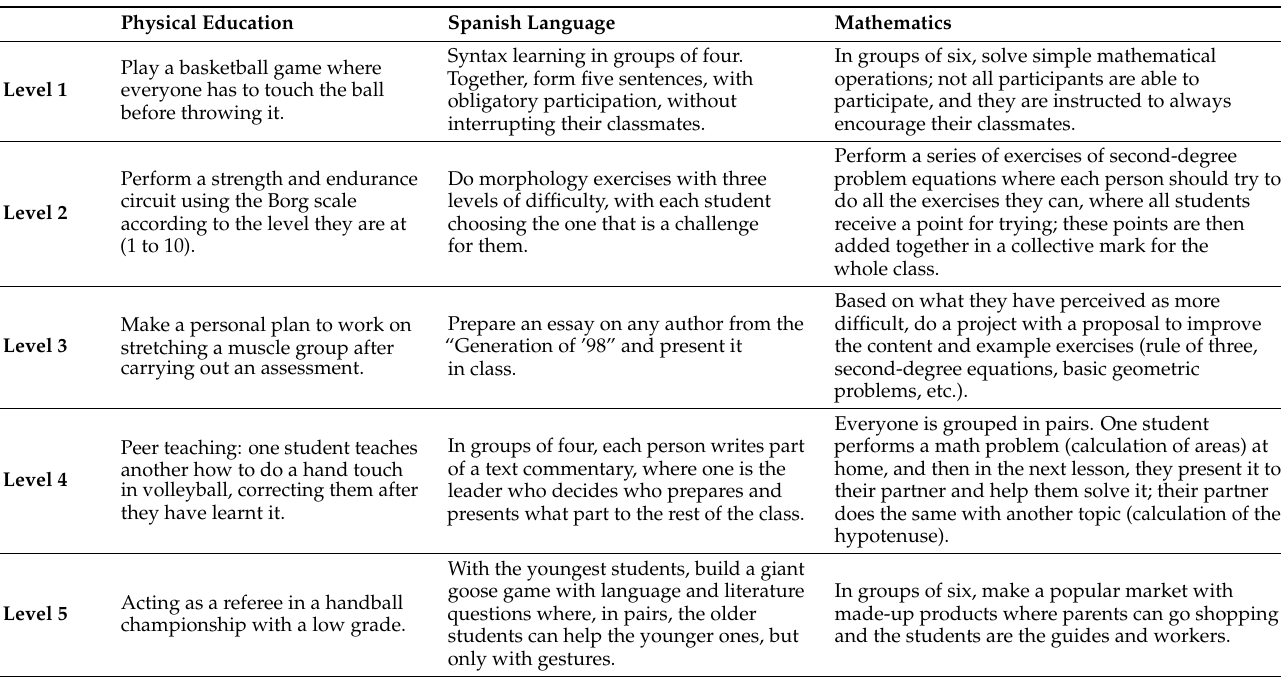
Table 1. Task examples in three different